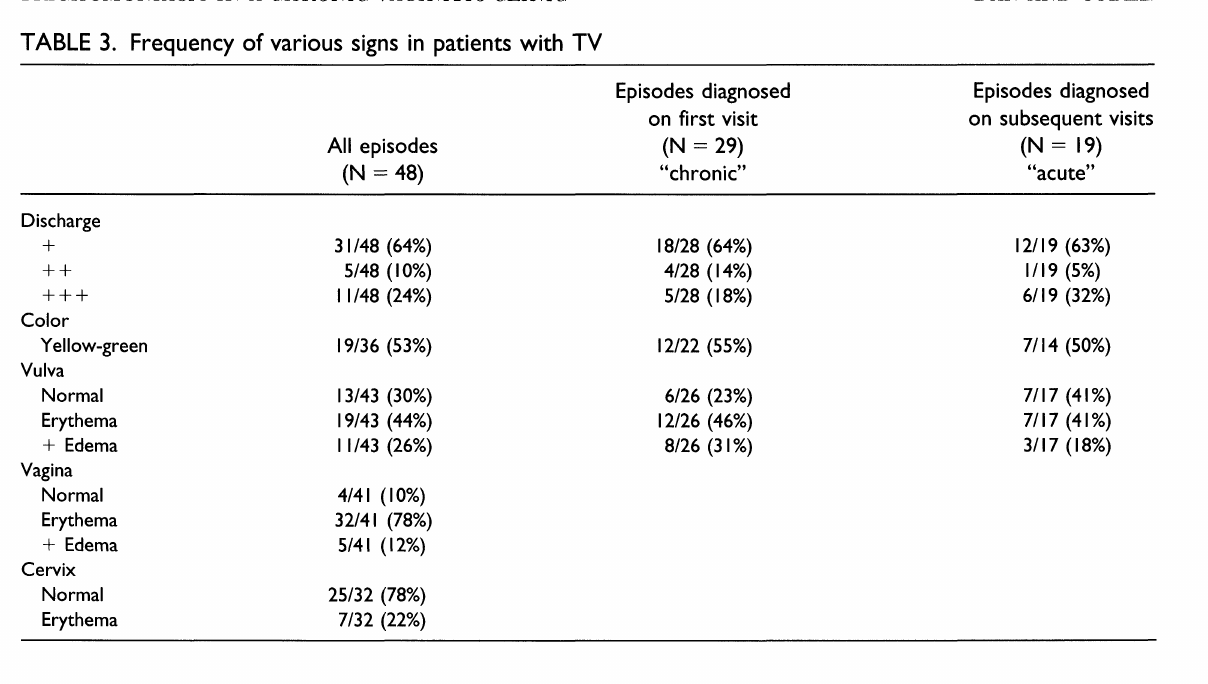
TABLE 3. Frequency of various signs in patients with TV Episodes diagnosed Episodes diagnosed on first visit on subsequent visits All episodes (N 48) "chronic"